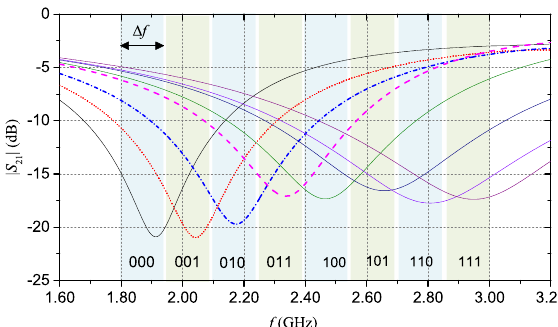
Figure 7. | S 21 | simulation results for the hairpin resonator. Each curve corresponds to a different configuration of the resonator. c (cid:13) [2019] IEEE. Reprinted, with permission, from [19].